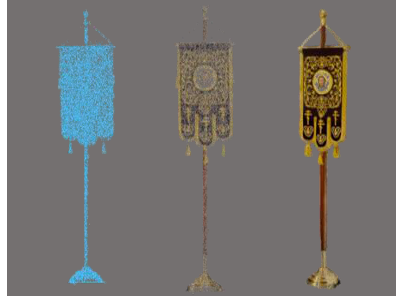
Figure 8 . Three types of visualisation: neutral sparse cloud and dense cloud for lock-unlock puzzles, mesh for solved puzzles.